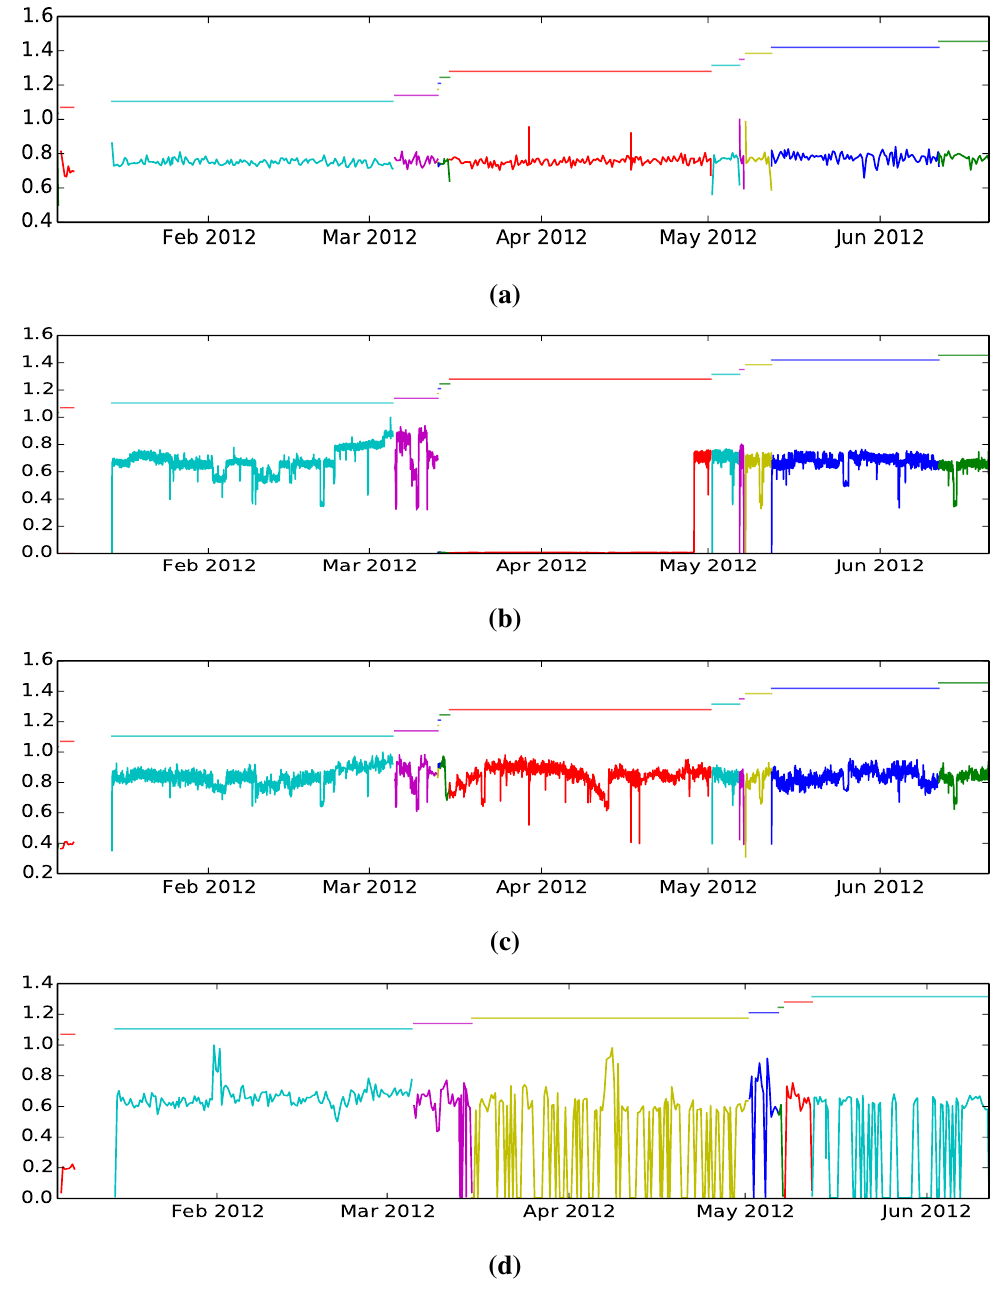
Figure 3. A sample of the four main types of time series contained in the dataset. We have marked with color changes the moments in which the machine was switched on/off. ( a ) Homogeneous time series; ( b ) unstable/noisy time series; ( c ) multi-modal series; ( d ) highly unstable time series, probably caused by faulty